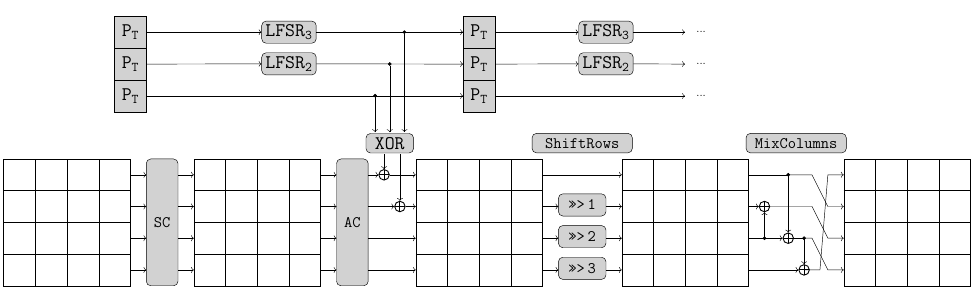
Figure 1: A high level schematic of SKINNY - n -3 n round function with the key schedule